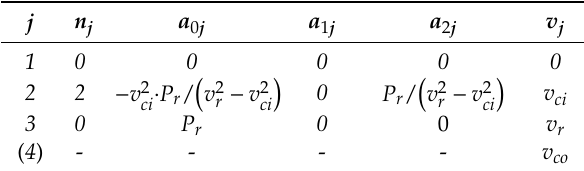
Table 2. Relationship among parameters of the quadratic models and the parameters of the